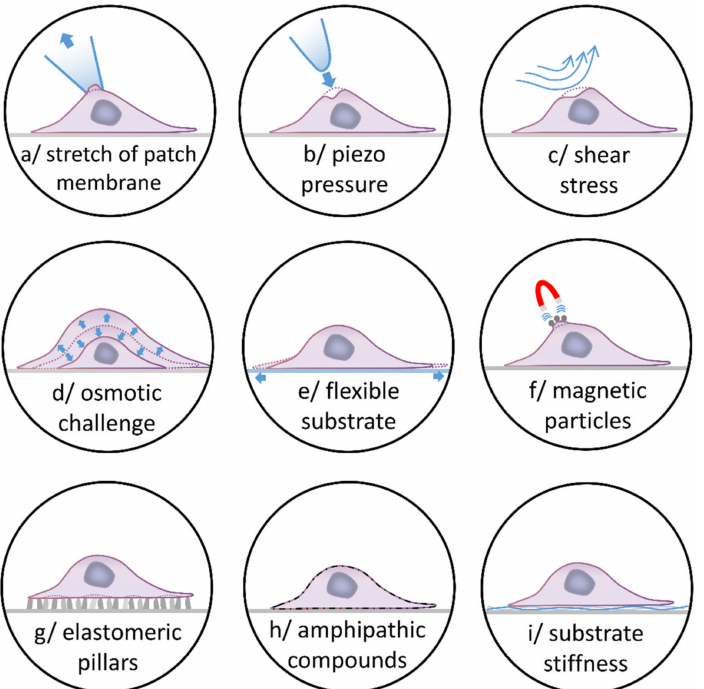
Figure 3. Experimental strategies to investigate SAC in cells. At the cellular level, several strate- gies can be used to activate SAC. The most commonly used are based on membrane deformation: ( a ) applying positive or negative pressure to the back end of the patch pipette, ( b ) poking of the cell membrane by a piezo-driven glass pipette, ( c ) modifying the perfusion flow or the viscosity of the solution, ( d ) using osmotic challenges: hypotonicity induces cell swelling, whilst hypertonicity evokes cell-shrinkage, ( e ) elongating thin elastic silicone membrane where cells are seeded, ( f ) apply- ing magnetic field to specific ligands coated with magnetic particles on the cells, ( g ) seeding cells on elastomeric pillars to apply force to specific parts of the cells, and ( h ) using crenators and cup formers (amphipathic compounds) to induce crenation or cup shapes. ( i ) Another alternative consists in culturing cells in matrices of different stiffness, to evaluate the impact of the environment matrix and more especially its